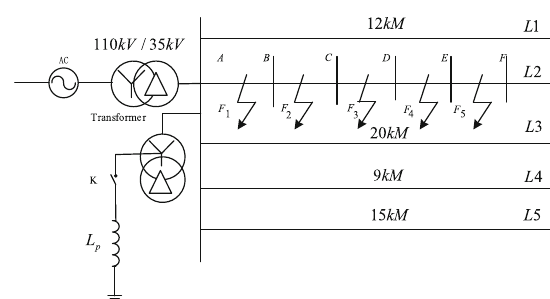
Fig. 6 Multi-feeder distribution network